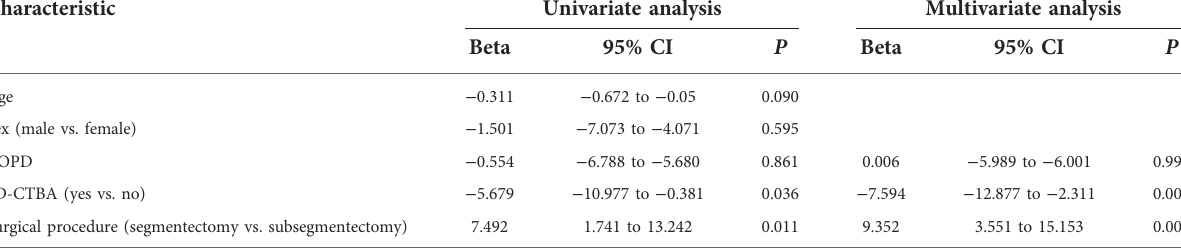
TABLE 3 Univariate/multivariate analyses of risk factors for intraoperative blood loss in patients who underwent segmentation of the right upper lobe.